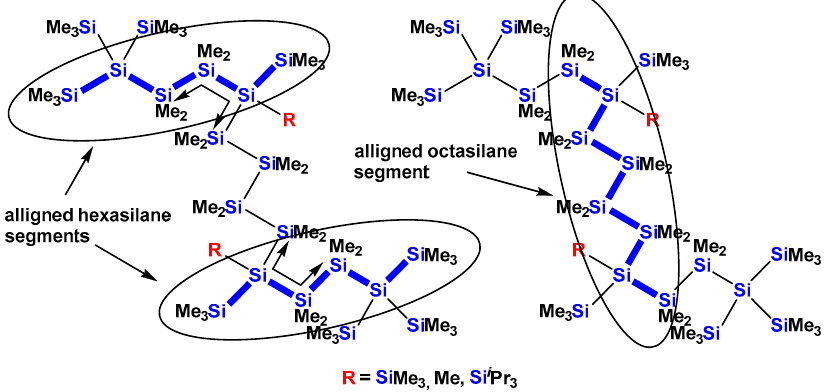
Figure 2. Schematic representation of the preferentially existing conformer of a permethylated tetradecasilane with geminal trimethylsilyl substitution at the 2, 5, 10, and 13 positions. Terminal transoid aligned hexasilane segments marked on the left side, a transoid aligned octasilane segment on the right side.